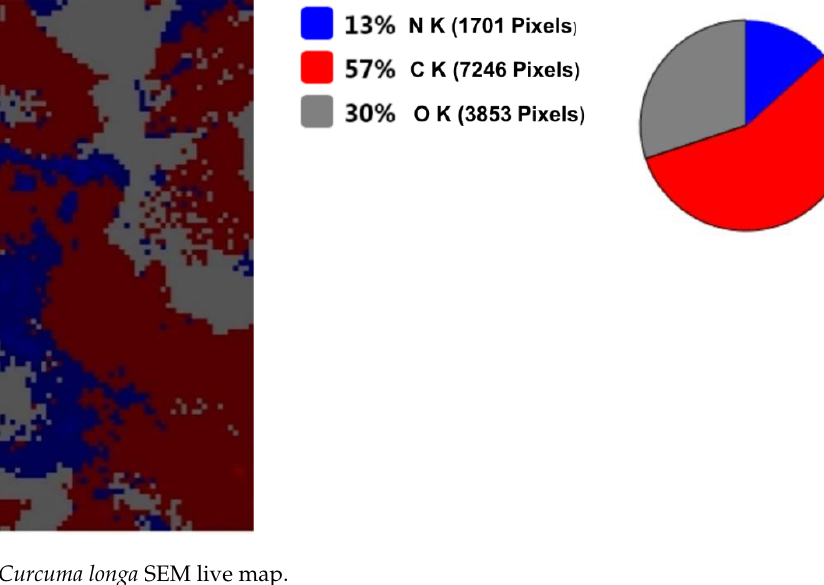
Figure 15. Curcuma longa SEM live map.